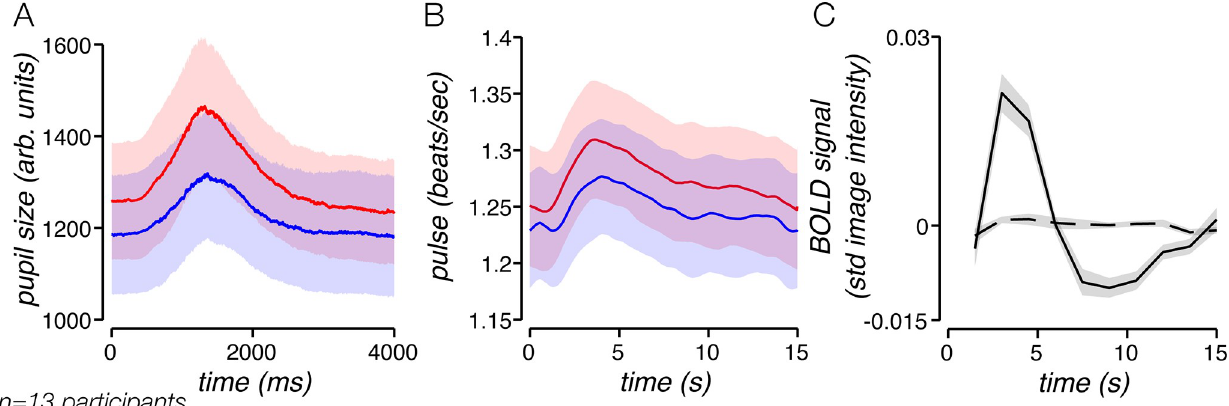
Fig 2. Reward modulates arousal, evident in pupil size and heart rate. (A) Mean pupil size for high- and low-reward trials. Pupil size exhibited a response that was time-locked to trial timing, showing an increase at the beginning of the trial followed by a return to baseline by 4 s. High-reward runs (red) evoked larger task-related pupil changes than low-reward runs (blue). (B) Heart rate for mean trial, averaged across participants. Heart rate exhibited a task-related response and was greater for high reward (red) than for low reward (blue). (C) Pulse-to-BOLD kernel before (solid line) and after (dashed line) global signal regression. Shaded regions, ± SEM across participants. Underlying data can be found at https://osf.io/cbjq6/. arb., arbitrary; BOLD, blood oxygen level–dependent; std, standard deviation.